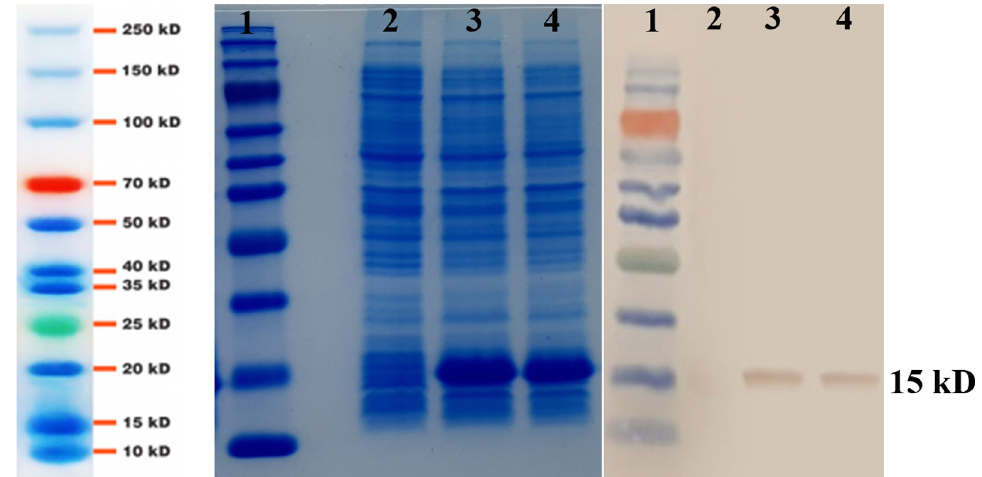
Fig 6. SDS-PAGE and Western blotting analysis of the recombinant proteins. Lane 1, protein marker (10–250 kDa). Whole lysate of BL21(DE3)-pET-22b without gene (lane 2), expressed wtIL-2 (lane3), mutant IL-2 (lane4).